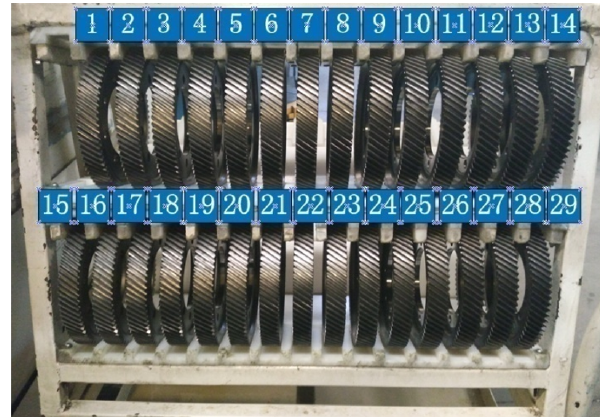
Figure 4. Workpiece gears of IGPH